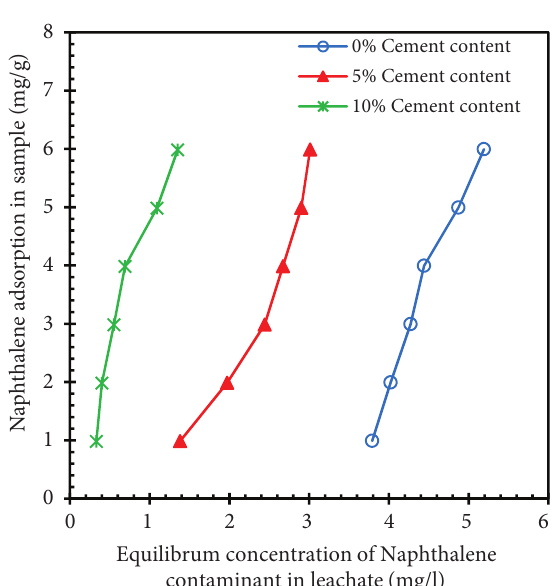
Figure 8. Adsorption isotherms for